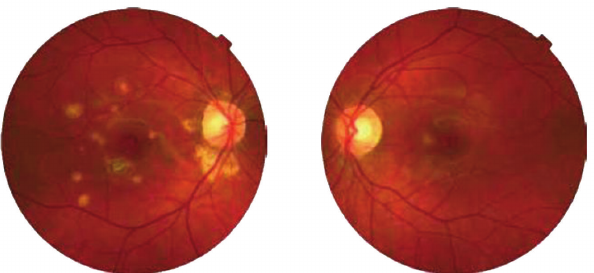
Figure 1: Right and left fundus photos of patient with recurrent punctate inner choroidopathy. Right fundus shows multiple yellowish- white chorioretinal lesions, some appear atrophic, localized to the posterior pole. Just inferior to the fovea is a pigmented scar from a successfully treated choroidal neovascular membrane. The left fundus shows a new focal yellowish chorioretinal lesion with surrounding fluid not documented on previous fundus photographs.